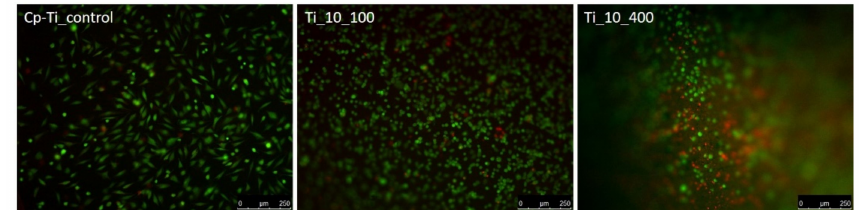
Figure 13. Micrograph of cell culture on the surfaces of deposited coatings; scale bar = 250 µ